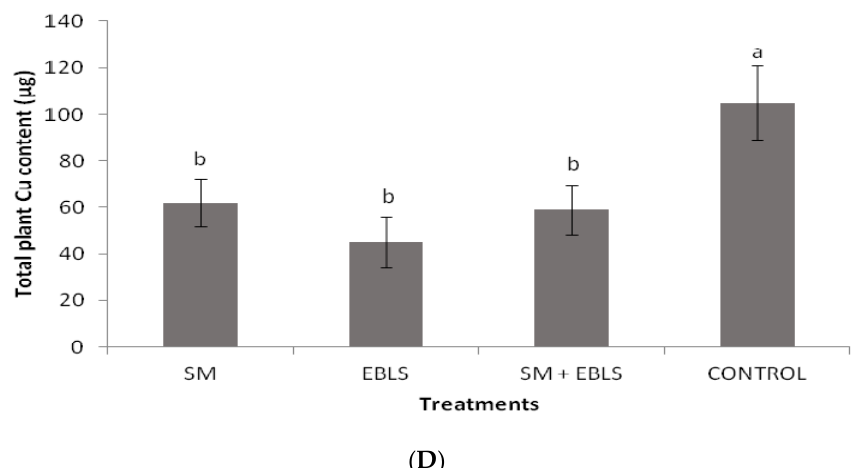
Figure 2. Total plant Fe ( A ), Mn ( B ), Zn ( C ), and Cu ( D ) content among the treatments. The different letters on the bars symbolize statistically significant differences among the treatments, according to Duncan’s multiple range test for p ≤ 0.05. SM = sheep manure; EBLS = organic material (litter) from evergreen broadleaf species, i.e., from Quercus sp.